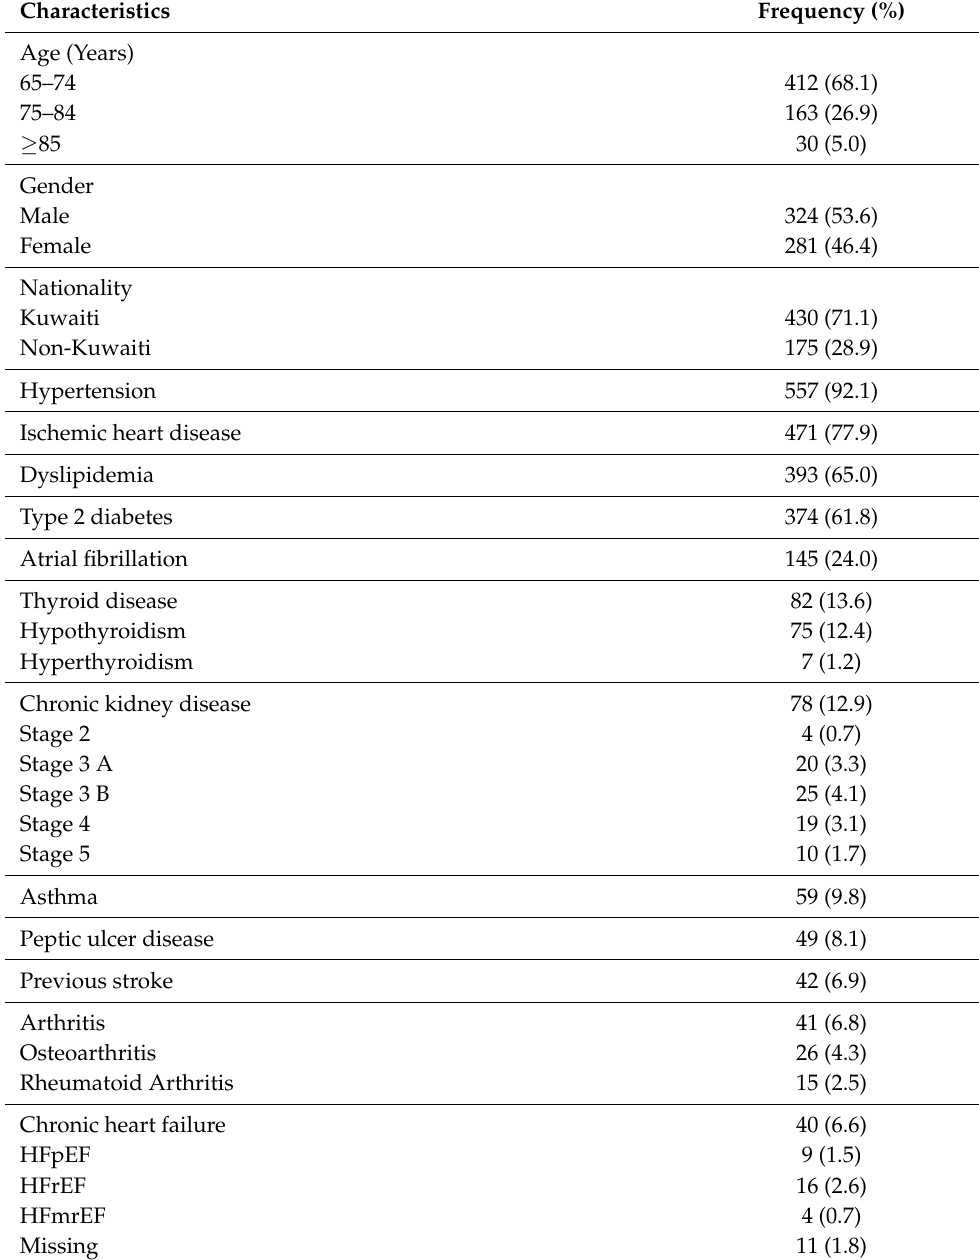
Table 1. Demographic and clinical characteristics of the patients ( n =